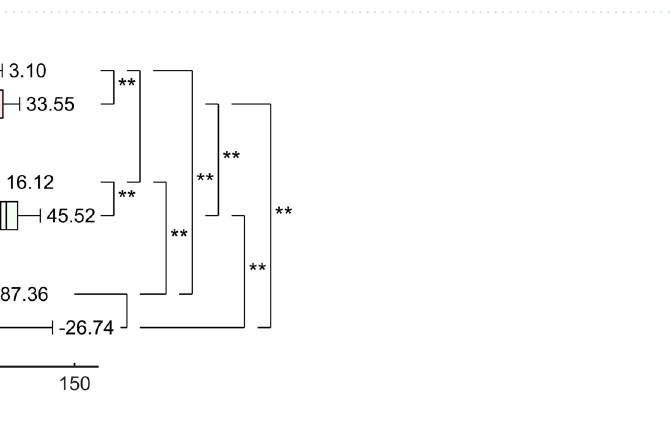
Figure 4. The timepoints at which significant changes occurred. Timepoints at which significant seizure- related changes occur are shown in the box-and-whisker plots. Median timepoints of each group are indicated as numerical values and the center mark on each box. For HFA and ISA, the change in the SOZ contacts occurs significantly before that of the nSOZ contacts. The time of PAC (i.e., ISA-HFA SIm) is earlier than that of SO (0 s). No significant differences exist between the times of SOZ-PAC and nSOZ-PAC. **Corrected p < 0.01, Wilcoxon rank-sum test across contacts, nine multiple comparison corrected by Bonferroni